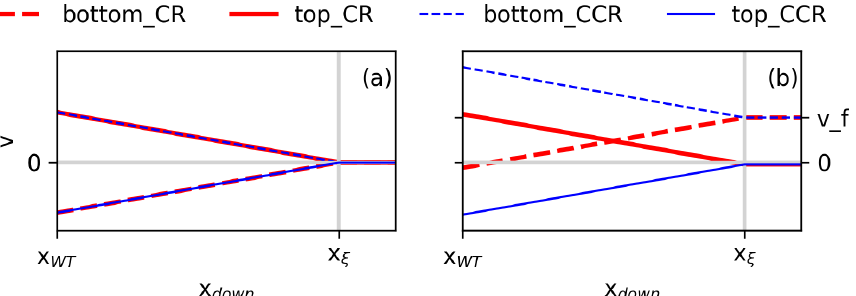
Figure 4. Downstream dependence of v ( z, x down ) at z = z h − R as “bottom” and z = z h + R as “top” considering a centre of the rotating system at z h with a radius R . CR and CCR correspond to the clockwise and counterclockwise rotational directions of the rotor.